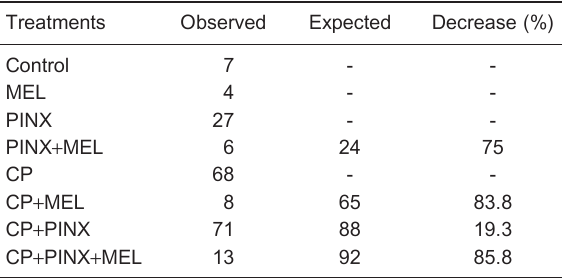
Table 3. Analysis of chromosomal aberrations after melatonin